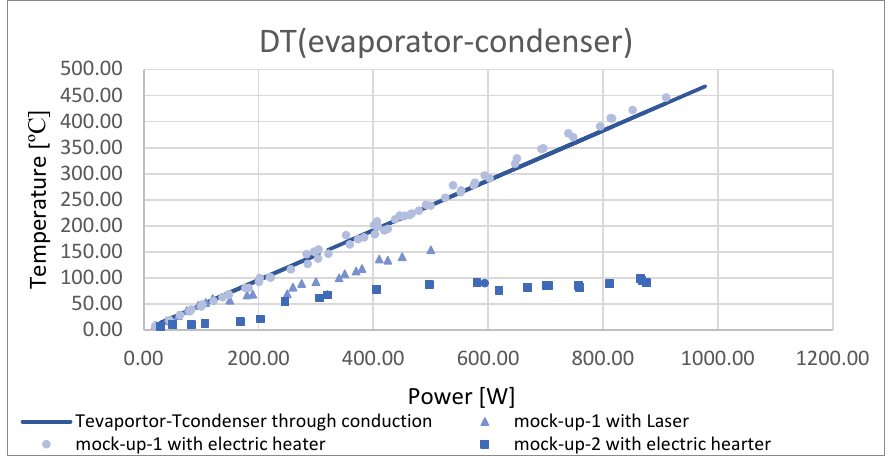
Figure 18. Variation in the temperature drop between the evaporator and condenser with the transferred power for all testing campaigns.